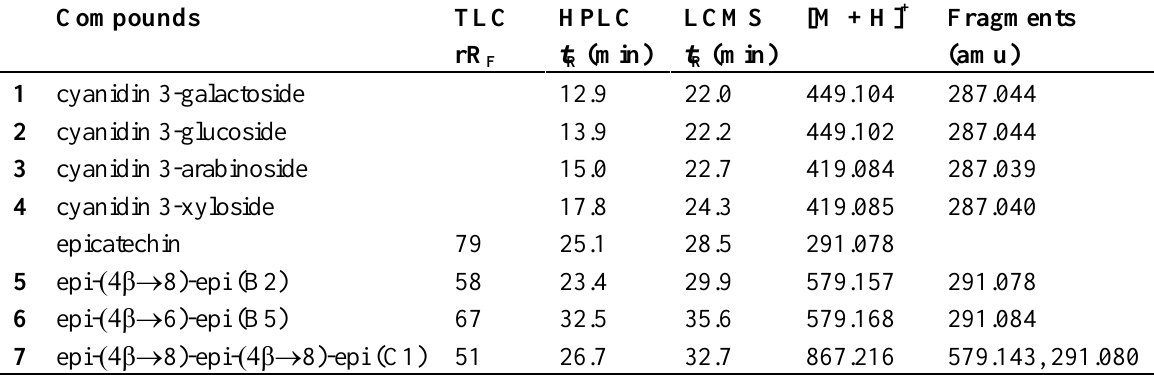
Table 1. Chromatographic and spectral characterization of anthocyanins and procyanidins from Aronia